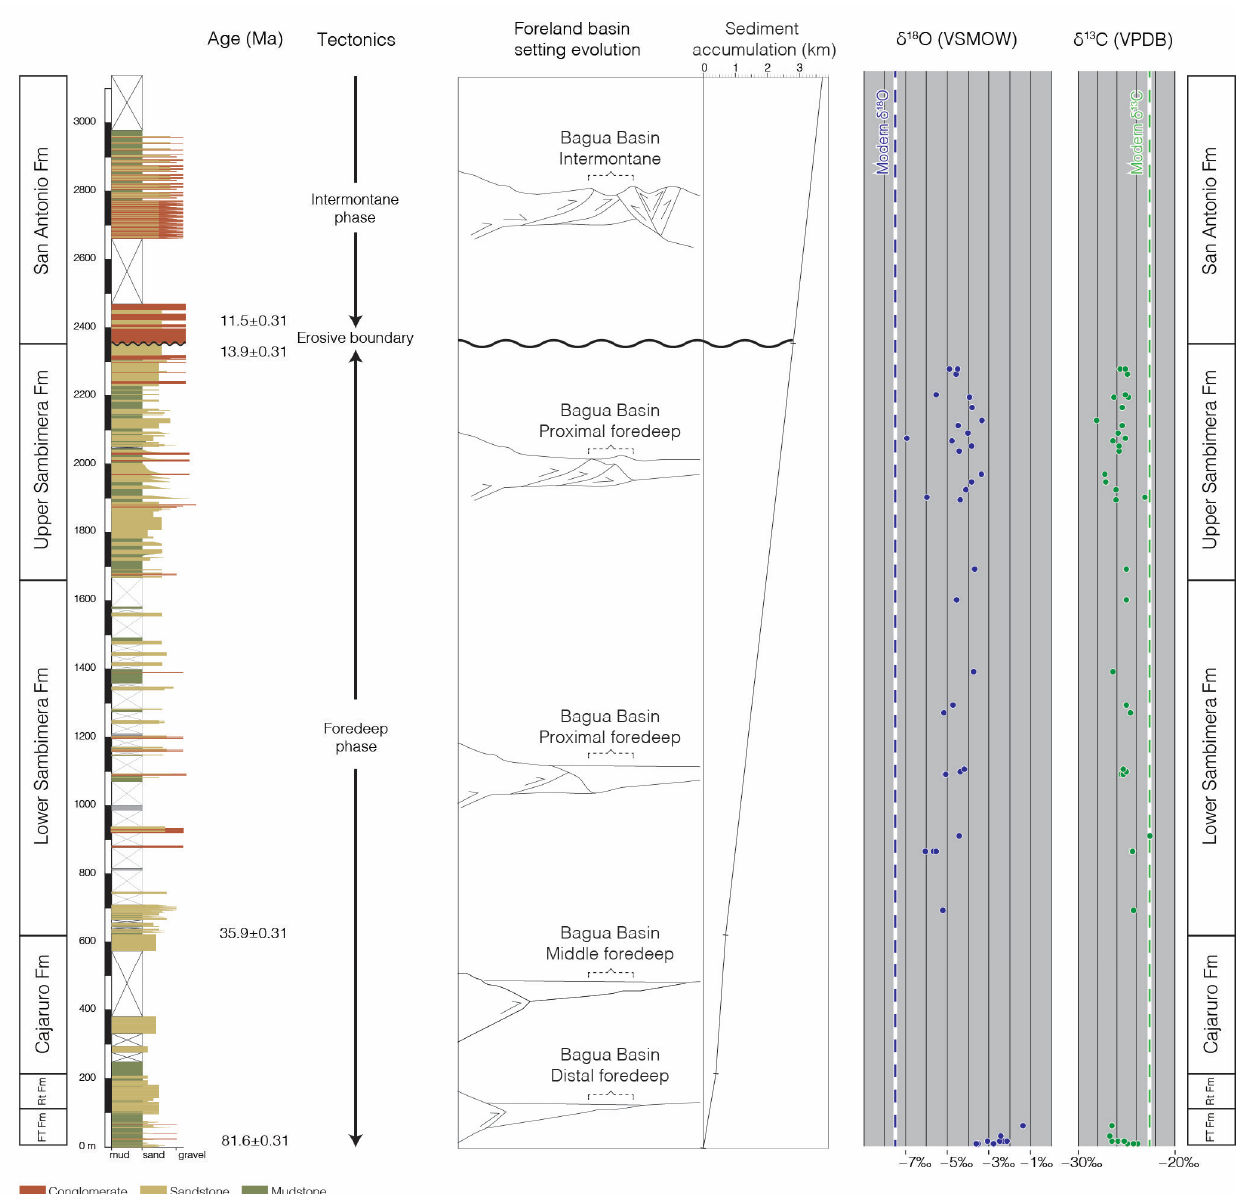
Figure 2. Generalized stratigraphic section of the Campanian to Pliocene sedimentary succession in Bagua Basin. Age constraints are maximum depositional ages from zircon U-Pb geochrononology from Moreno, et al. (2020) [25]. Panels in the left shown from left to right, tectonic and foreland basin setting, historical de-compacted sediment accumulation curve [25], and δ 18 O mw and δ 13 C o results for the Fundo El Triunfo and Sambimera formations. Blue and green dashed vertical lines indicate the average modern signature for δ 18 O mw and δ 13 C o calculated as the arithmetic mean of the δ 18 O values of the water samples collected in the Bagua Basin and of the δ 13 C of the plants collected in the Bagua Basin respectively. Analytical errors (1 sigma) are smaller than ±0.1 for δ 18 O and smaller than ±0.06 for δ 13 C. Abbreviations: FT Fm = Funfo El Triunfo Formation; Rt Fm = Rentema Formation.